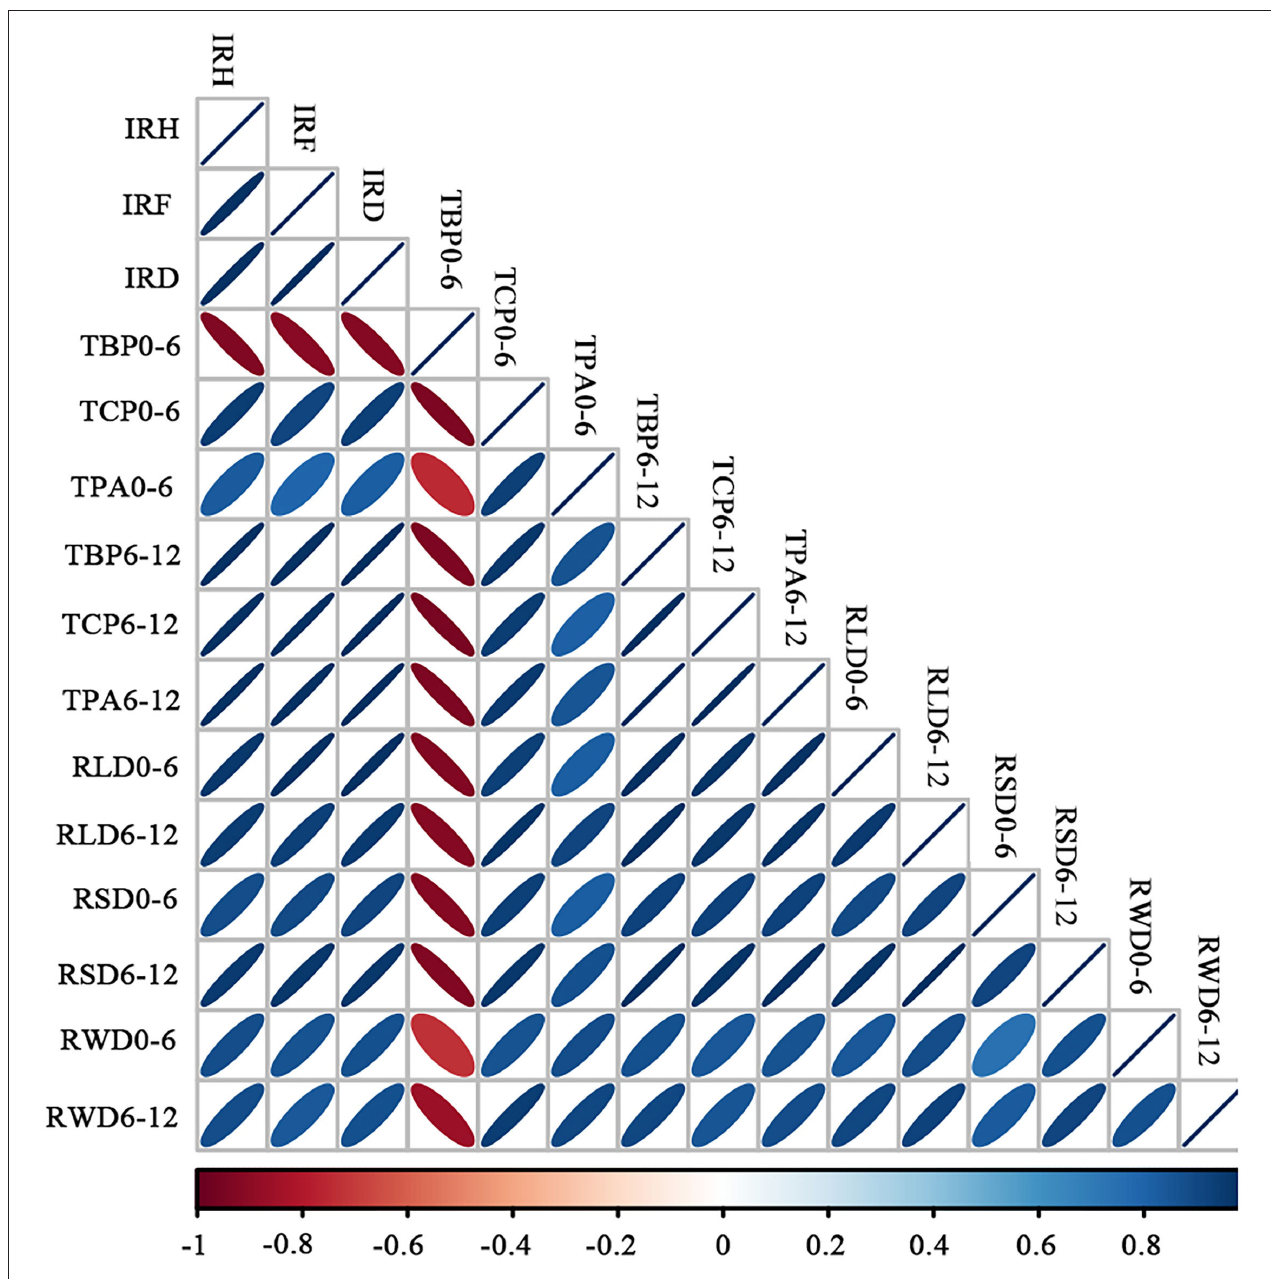
FIGURE 5 | Correlation plot between allelopathic activity, rice allelochemicals in soil, and root parameters at a lateral distance. IRH, rice allelopathic activity (% inhibition on plant height of barnyardgrass); IRF, rice allelopathic activity (% inhibition on fresh weight of barnyardgrass); IRD, rice allelopathic activity (% inhibition on the dry weight of barnyardgrass); TBP, the content of benzoic acid derivatives in soil; TCP, the content of cinnamic acid derivatives in the soil; TPA, total phenolic acid content in soil; RLD, root length density; RSD, root surface area density; and RWD, root dry weight density. The gradient of the legend is a function of the strength of the correlation; while the slope of the ellipse indicates a negative or positive correlation (i.e., toward the left is a positive correlation and toward the right is a negative correlation). The shape of the ellipse indicates the strength of the correlation; a diffuse shape indicates a weak